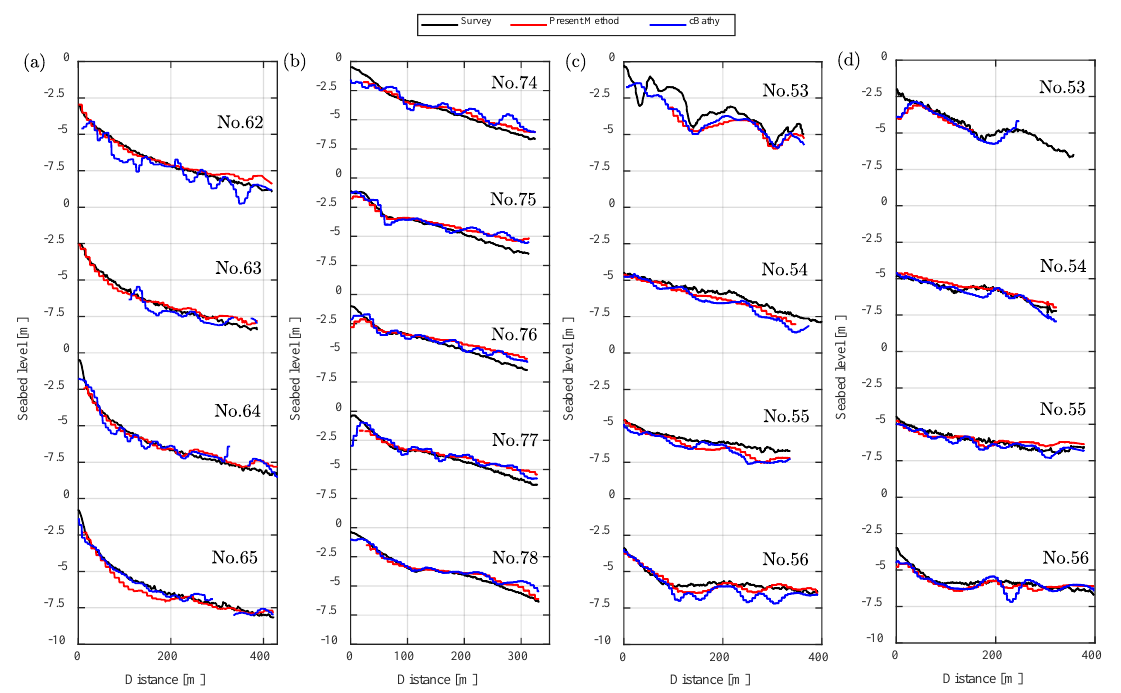
Figure 10. Comparisons of seabed profiles by the present method, cBathy and survey data (RC boat) along the transects: ( a ) Case 1, ( b ) Case 2, ( c ) Case 3 and ( d ) Case 4. Table 3. Validation results: RMSE averaged over the transects, domain-averaged wave period and cross-correlation, and video-shooting and survey dates.